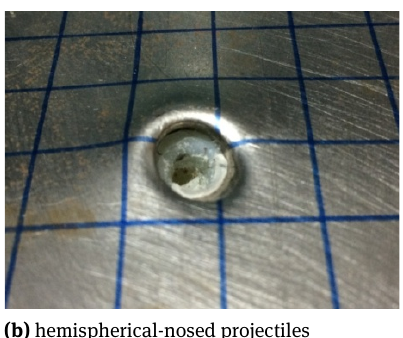
Figure 5: Dimension of sabot